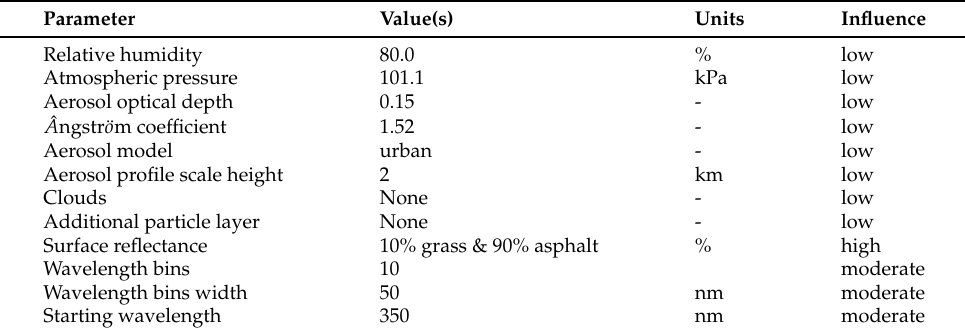
Table 2. Uniform all over the domain input parameters used for the modeling. All parameters are required by Illumina v2 but the last column indicate the importance of the parameter for obtrusive light calculations. The urban aerosol model refers to the aerosol composition and size distributions defined by